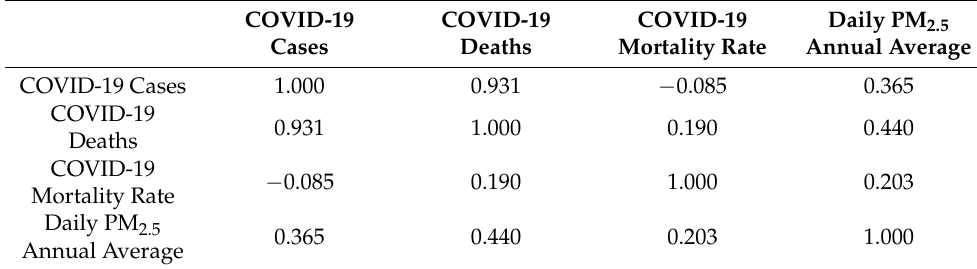
Table 2. Spearman’s rho correlation